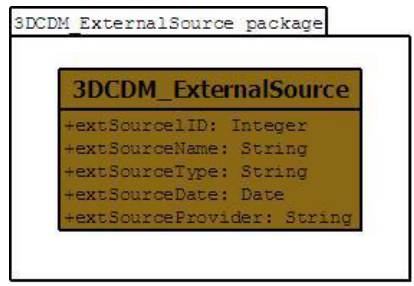
Figure 14. 3DCDM_ExternalSource Package